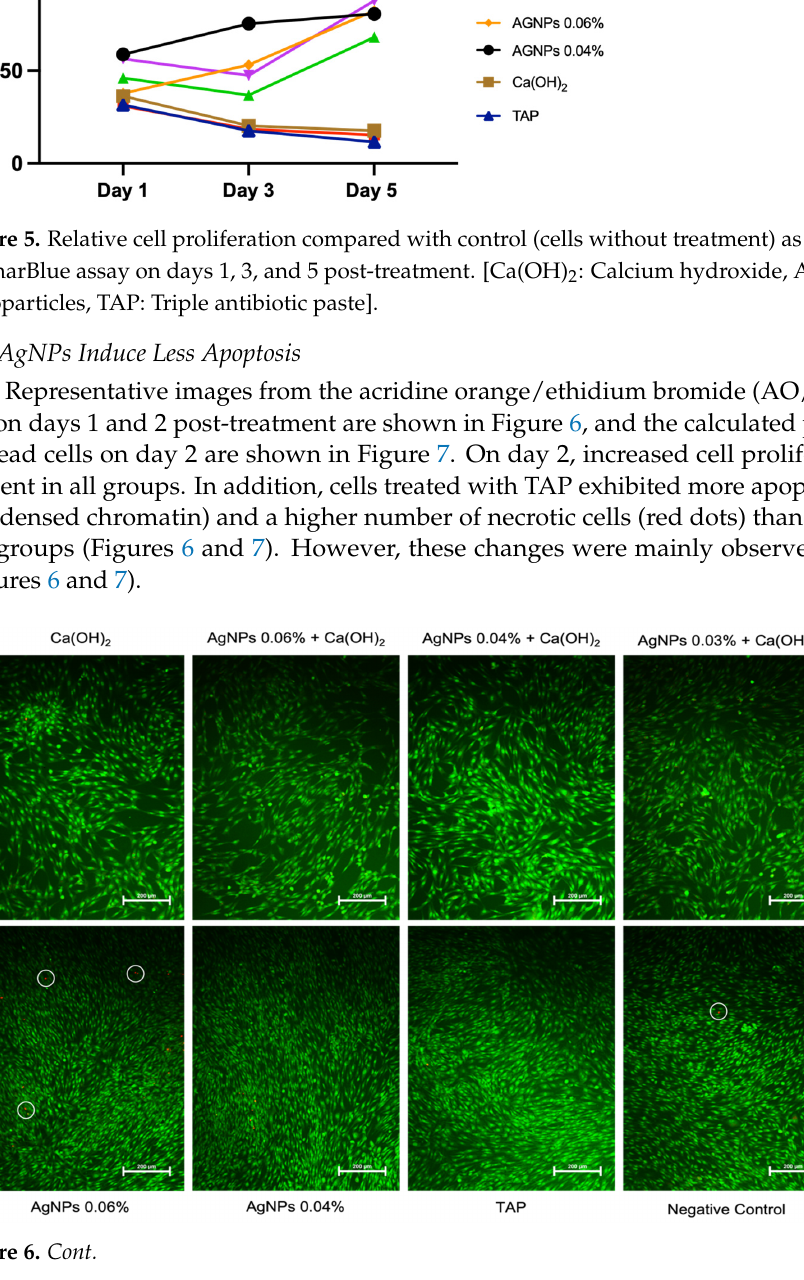
Figure 6. Representative fluorescence images (20x) of hBMSCs treated with the test medicaments, cells were stained with acridine orange/ethidium bromide AO/EtBr and micrographs were taken after 24 and 48 h. White circles on red dots indicate dead (necrotic) cells, yellow arrows point to